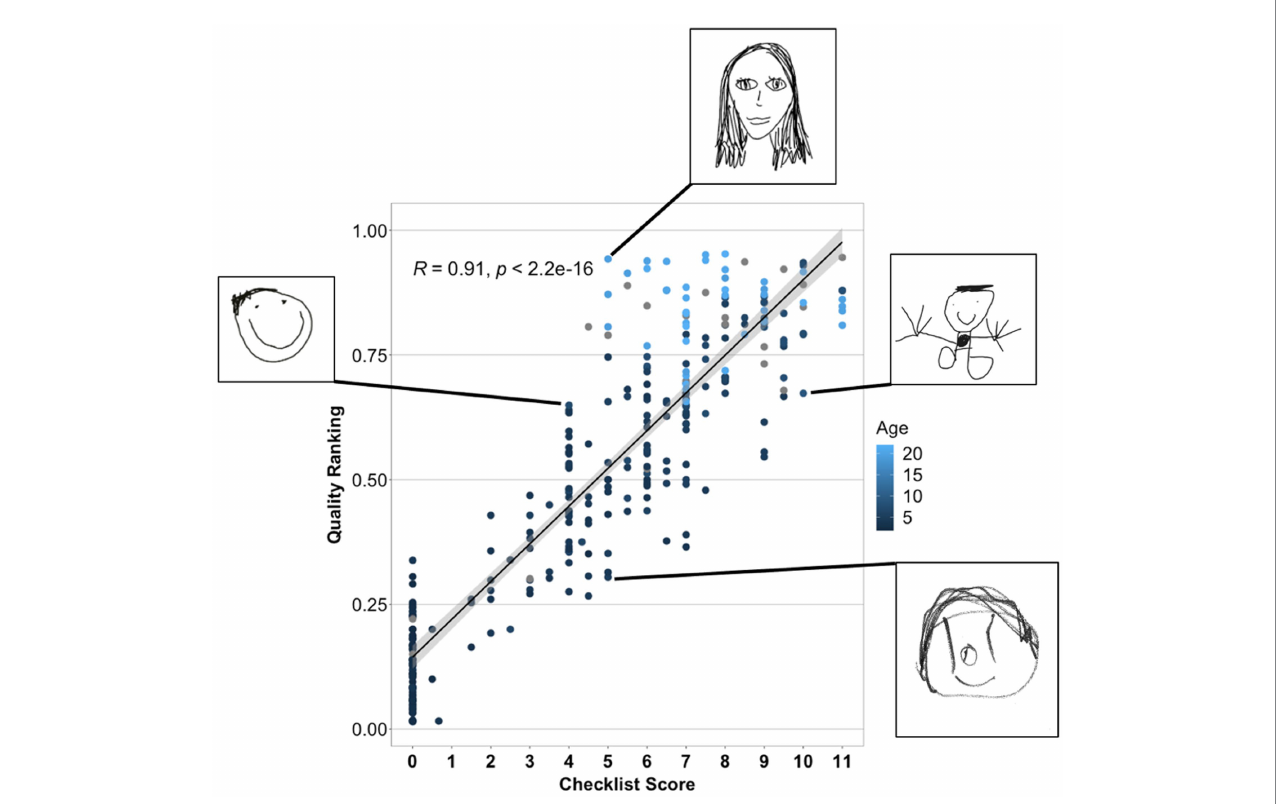
FIGURE 7 Relation between the crowd-sourced quality-ranking and the Draw-A-Child checklist score. The top and bottom callouts show drawings that received the same checklist score but differ in quality-rank, while the two middle callouts show drawings that received similar quality-rank scores but different checklist scores.